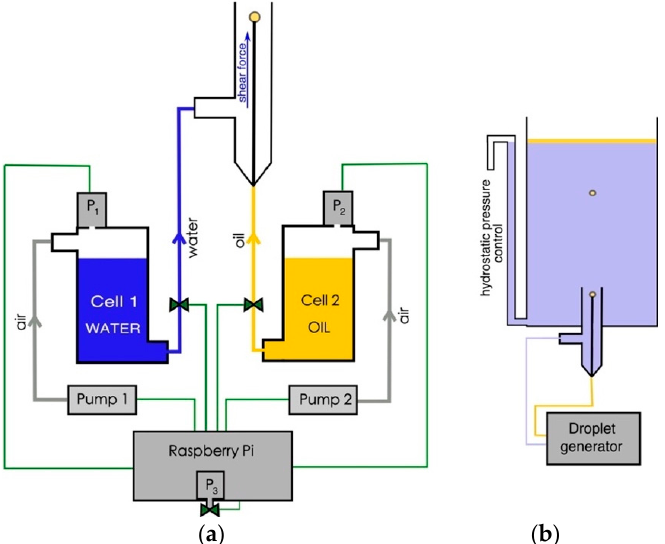
Figure 1. Schemes of: ( a ) Single droplet generator; ( b ) Experimental set-up used to study the single droplet size and its motion parameters.